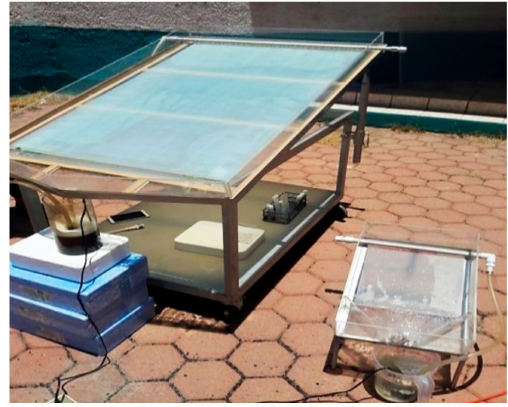
Figure 7. Solar reactors with 1 m 2 (left) and 1 / 10 m 2 contact surface